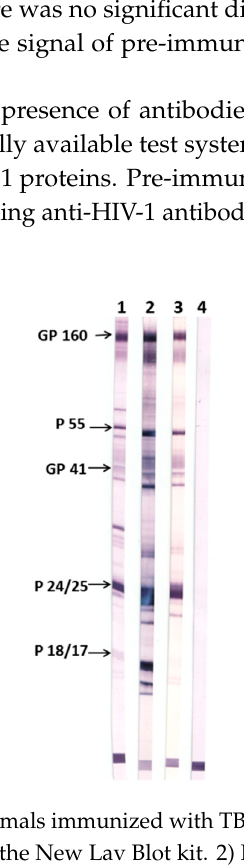
Figure 4. CD spectra of TBI_tag protein: ( A) saline; ( B) 20% trifluoroethanol in saline.